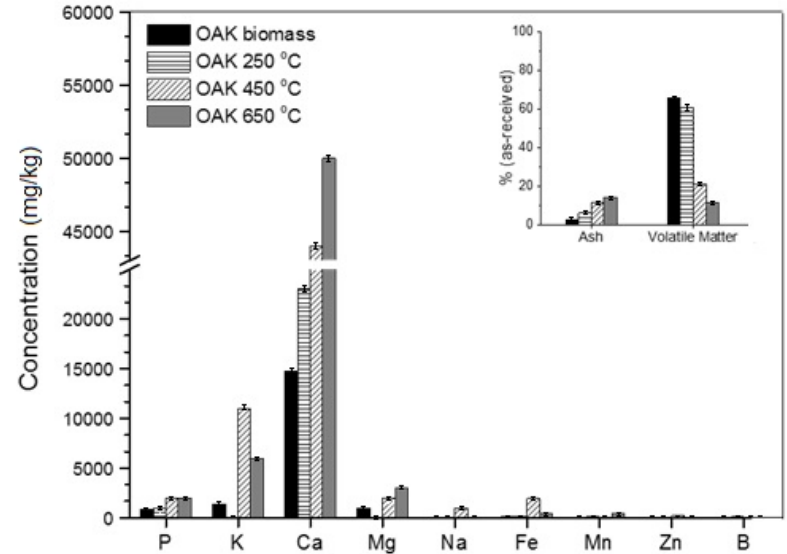
Figure 1. Distribution of the main micro- and macro-mineral contents within oak biomass, hydrochar, and biochars (mg/kg, dry basis). Inset: Ash and volatile content of oak biomass and chars (%wt., as received basis). Based on duplicate data with repeatability typically within ± 2%. Error bars represent deviation around the mean.